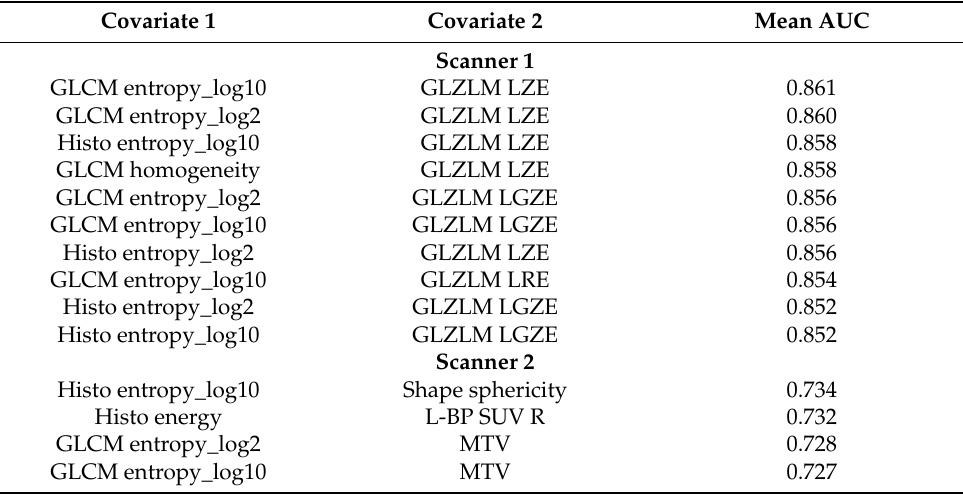
Table 5. Bivariate analysis regarding the prediction role of variables